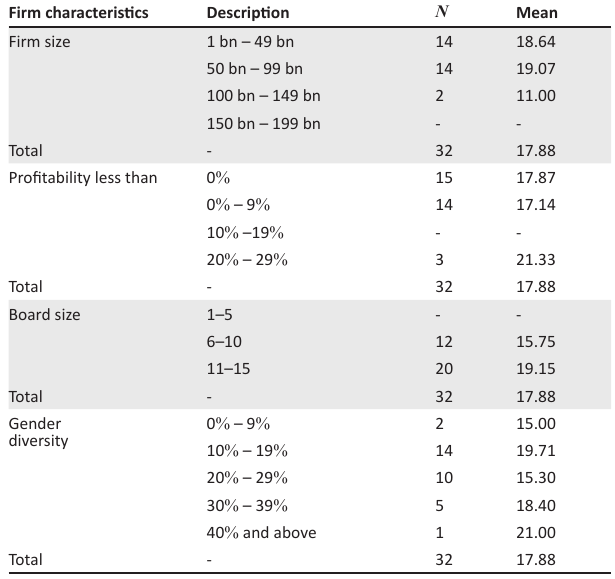
TABLE 4: Descriptive statistics for all the variables.